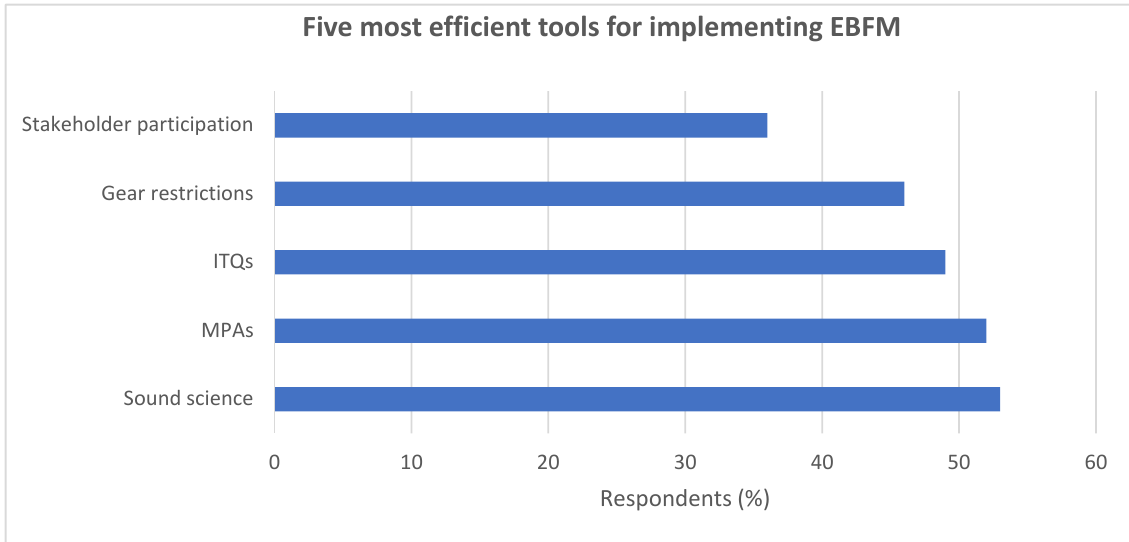
Figure 12. Participants’ responses to the five most-efficient regulations for Ecosystem-Based Fisheries Management (n = 121). ITQs, individual transferable quotas.